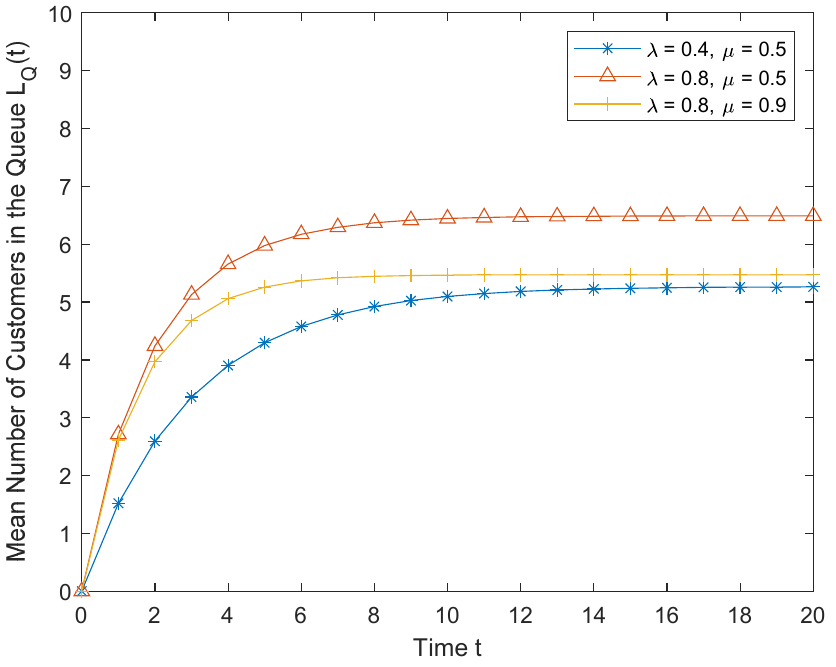
Figure 7. The mean number of customers in the queue L Q ( t ).